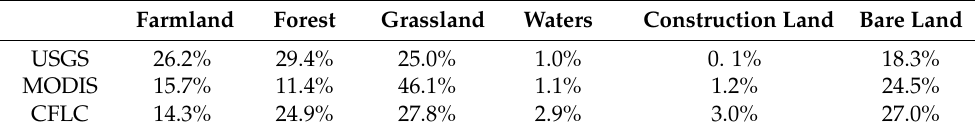
Table 7. The proportion of land cover types under a 6-class system between 3 data. Farmland Forest Grassland Waters Construction Land Bare